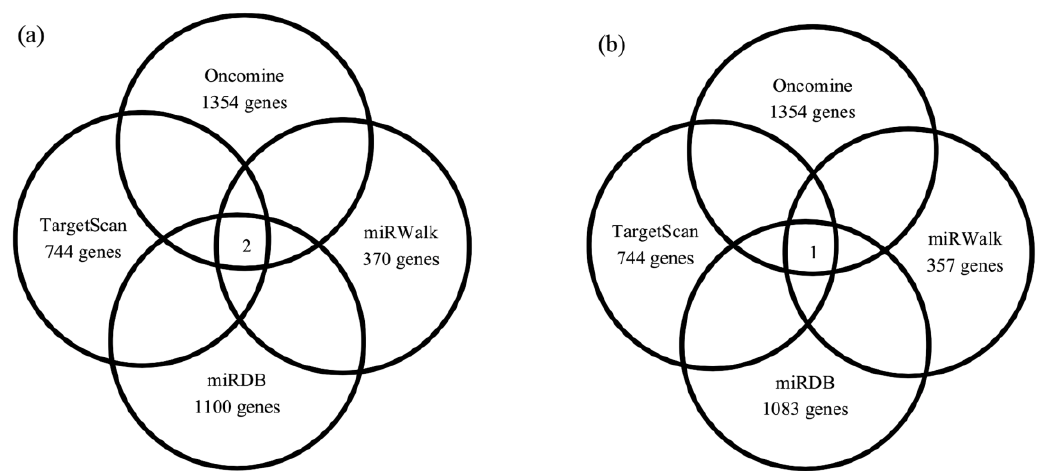
Figure 3. Venn diagrams showing the overlapping targeted genes for selected miRNAs as predicted by the bioinformatic analysis. ( a ) Two overlapping targeted genes for miR-141 were identified, namely DLC-1 and ZEB2 . ( b ) MiR-200a is a single predicted miRNA to target the ZEB2 gene, which overlaps in all datasets.